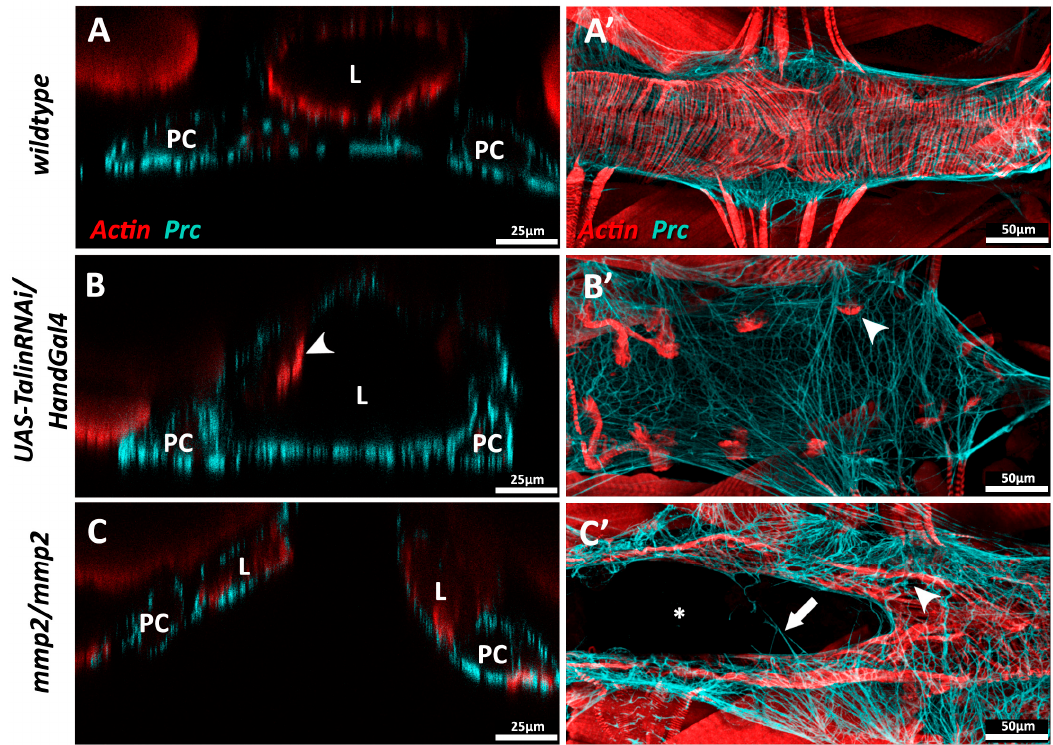
Figure 5. Mis-regulation of ECM proteins in Drosophila results in cardiac dilation or cardia bifida. ( A–A’ ) Wildtype third instar dorsal vessel in cross-sectional ( A ) and coronal view ( A’ ). Actin (red) forms regular transverse myofibrils along the length of the heart tube. Abluminal Prc networks (cyan) envelop the heart tube and pericardial cells (PCs); ( B–B’ ) Dorsal vessel of a third instar UAS-TalinRNAi/HandGal4 larva in which Talin expression has been inhibited via RNA interference in cardiomyocytes and PCs during late embryogenesis and throughout larval growth. ( B ) Cross-sectional view illustrating dilation of the cardiac lumen. Actin myofibrils do not fully envelop the heart tube, and appear constrained to the lateral regions of the vessel (arrowhead) ( B’ ) Actin myofibrils are fewer in number and reduced in length (arrowhead), and Prc bundles are more broadly distributed; ( C–C’ ) Homozygous third instar mmp2 w307 phenotypic null mutants show cardia bifida. ( C ) Cross-sectional view reveals two discrete heart vessels. The Prc network envelops the abluminal domains of both vessels. ( C’ ) Portions of the mmp2 mutant heart chamber are split, while other regions show successful contralateral contact between cardioblasts to enclose a singular lumen. A small number of Prc bundles connect the two discrete heart vessels (arrow). The Actin cytoskeleton appears disorganised; myofibrils envelop the heart vessels but gaps are visible between parallel fibres (arrowhead). L: heart lumen; PC: pericardial